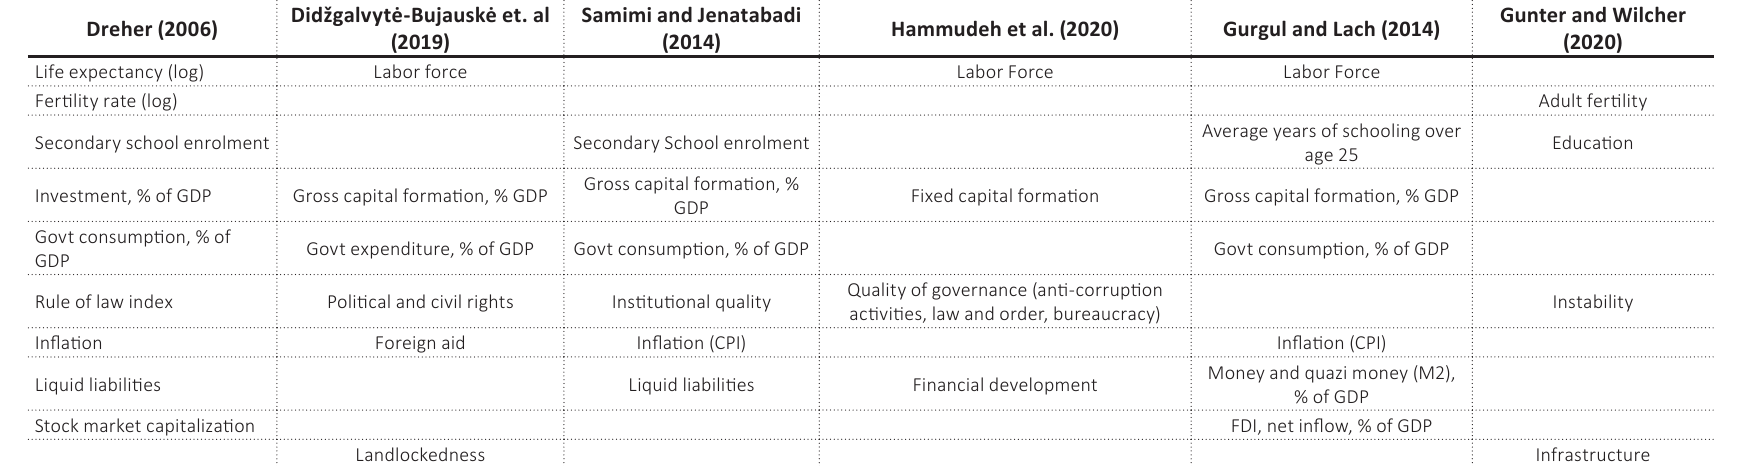
Table A1. Summary of variables in empirical studies on globalization-growth